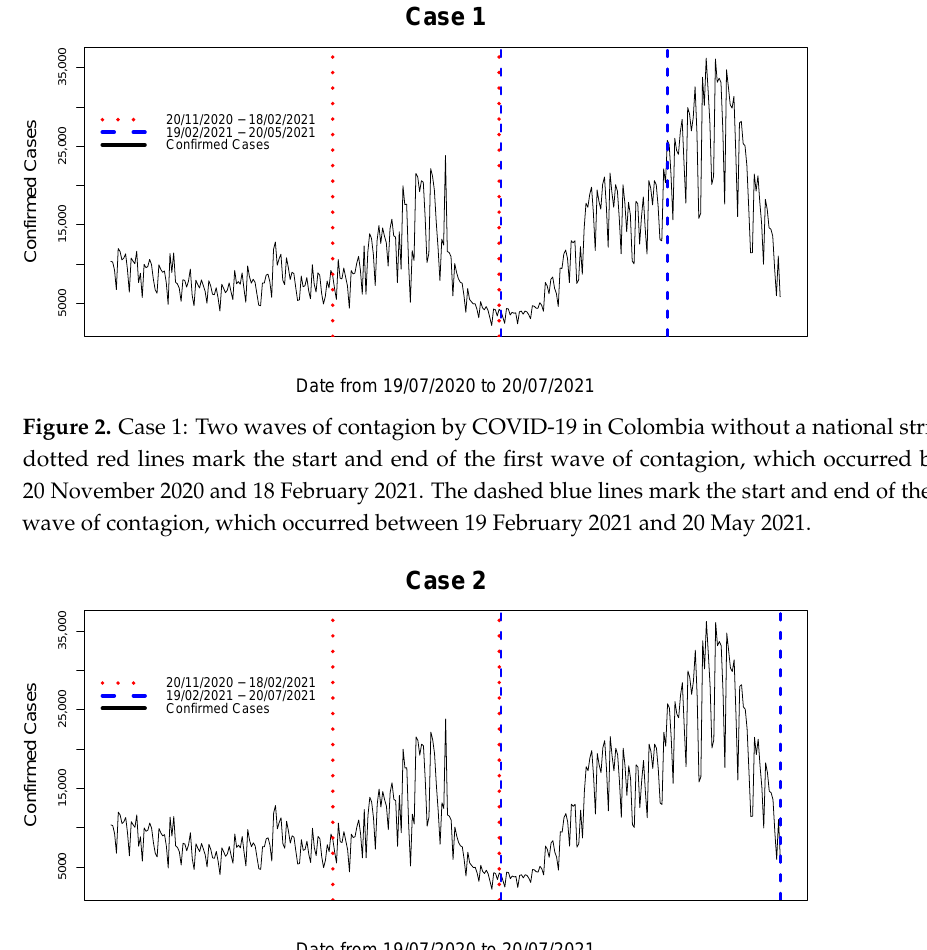
Figure 3. Case 2: Two waves of contagion by COVID-19 in Colombia with a national strike. The dotted red lines mark the start and end of the first wave of contagion, which occurred between 20 November 2020 and 18 February 2021. The dashed blue lines mark the start and end of the second wave of contagion, which occurred between 19 February 2021 and 20 July